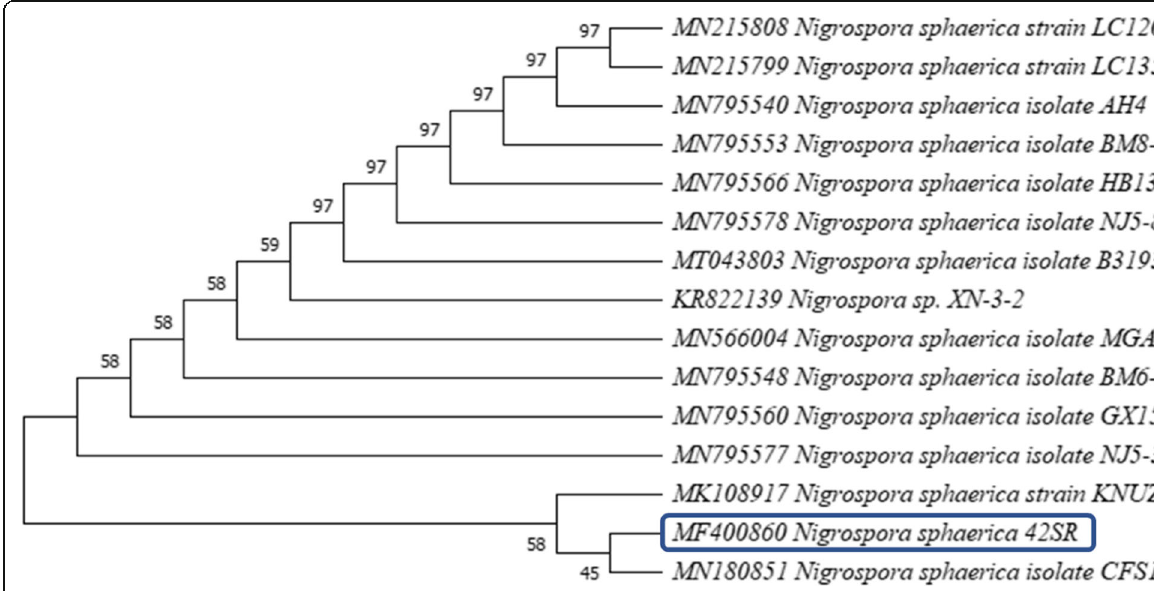
Fig. 2 Phylogenetic tree derived from neighbor-joining analysis showing the evolutionary relationship using the MEGA-X software